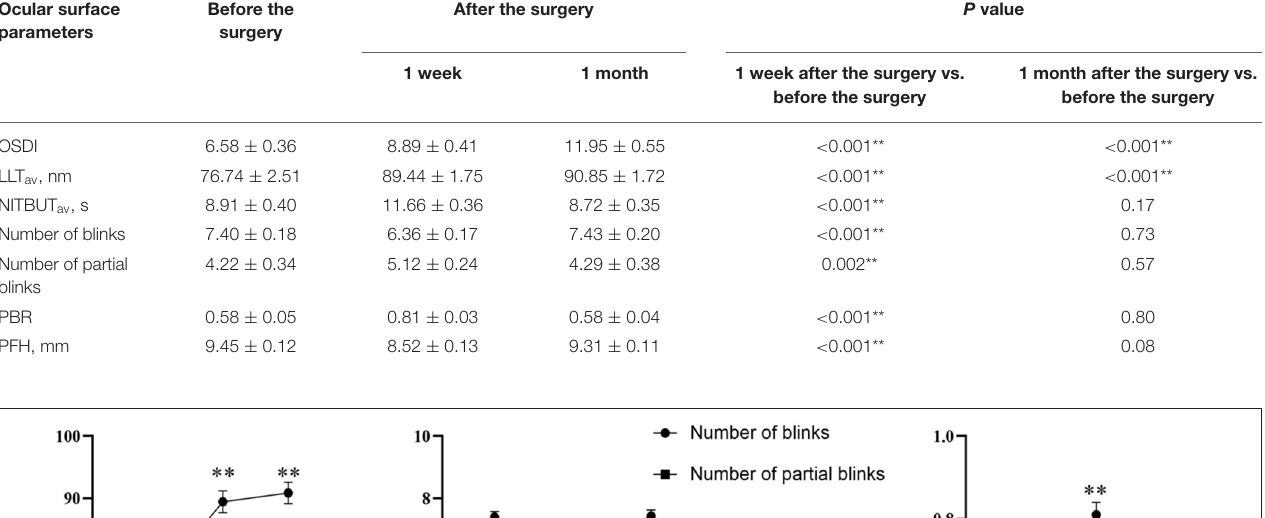
TABLE 1 | Comparison of preoperative and postoperative ocular surface parameters (** P < 0.001). Ocular surface parameters